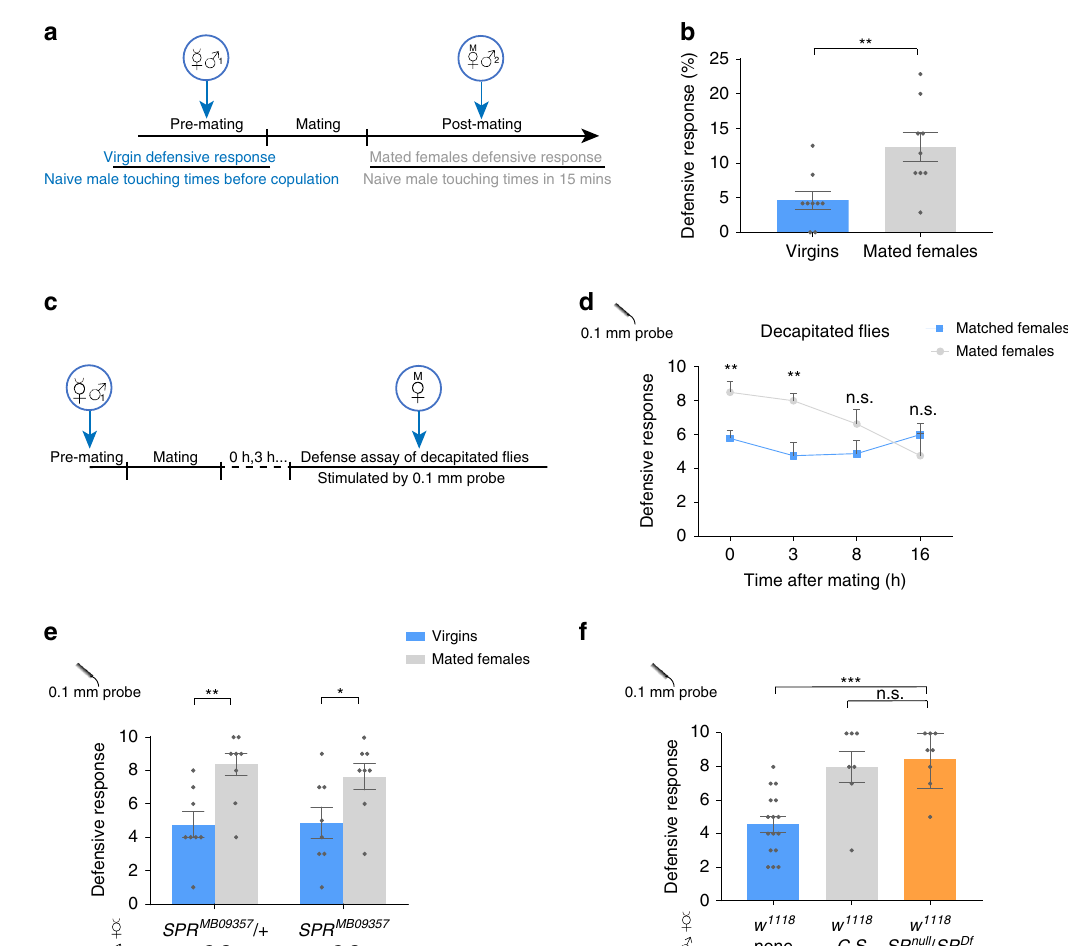
Fig. 3 Mating facilitates defensive response independent with SP. a Schematic for assays in ( b ). Defensive response ratio of virgin fl ies and newly mated females were tested for virgin or mated female defensive response stimulated by naïve males divided by naive male touching times. Male touching times to virgins were counted before copulation, and male touching times to mated females were record for 15 min. b Defensive response ratio was enhanced in newly mated females. n = 9 for each goup. ** p < 0. 01, two-tailed unpaired t tests. c Schematic for assays in d . Males were removed after copulation, and mated females were kept for given hours before the defensive response assay. d Copulation-induced increase of defensive response lasted for more than 3 h in decapitated fl ies. Matched females represented that virgins were placed solely in courtship chambers paralleled with mated females under